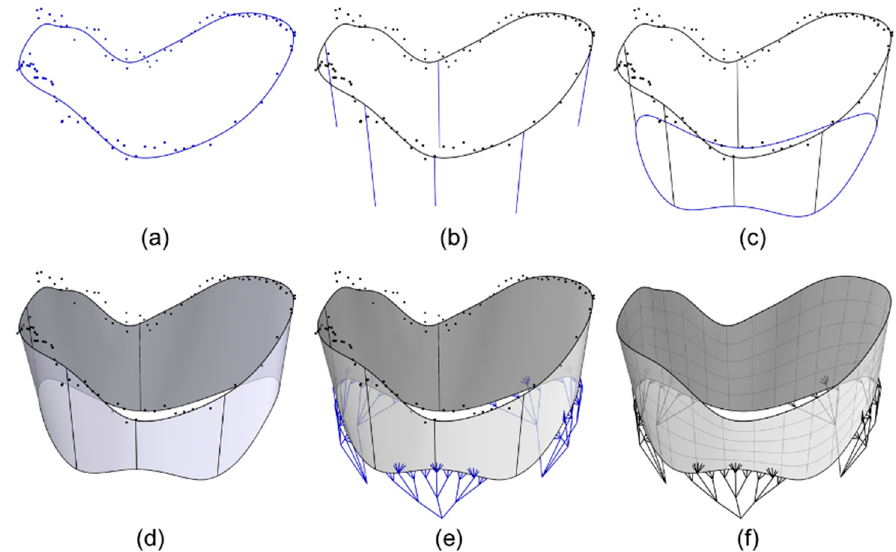
Figure 14. Geometry construction process for the parametric TV: ( a ) B-spline fit of the annulus from the scanned micro-CT data, ( b ) the definitions of the commissure height and the leaflet height, ( c ) a determination of the TV leaflet free edge, ( d ) an interpolation of the TV leaflet surface, ( e ) the attachment of chordae tendineae to the TV leaflets, and ( f ) the final geometry model.